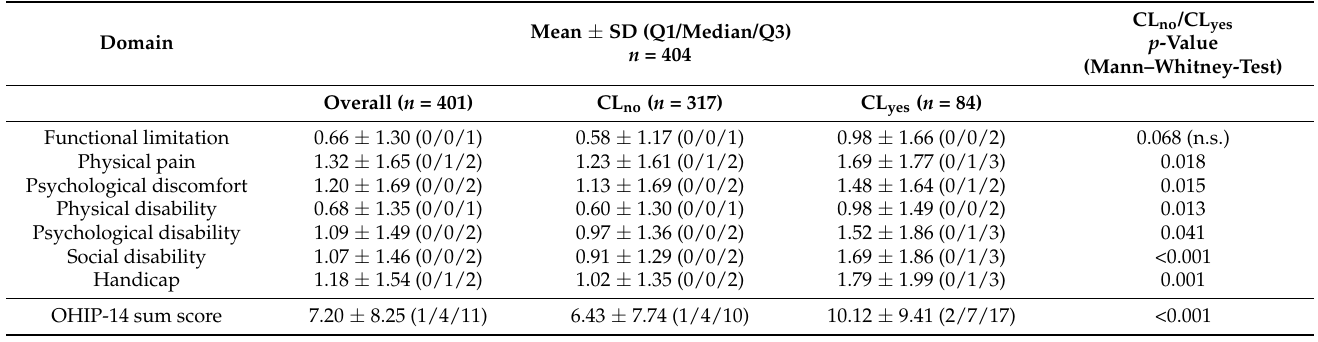
Table 3. Mean values and standard deviations of OHIP-14 domains and sum score; N = 401; Q1 = 25th percentile; Q3 = 75th percentile; significance of differences depending on absence/presence of care level (CL no /CL yes ); missing data due to incomplete